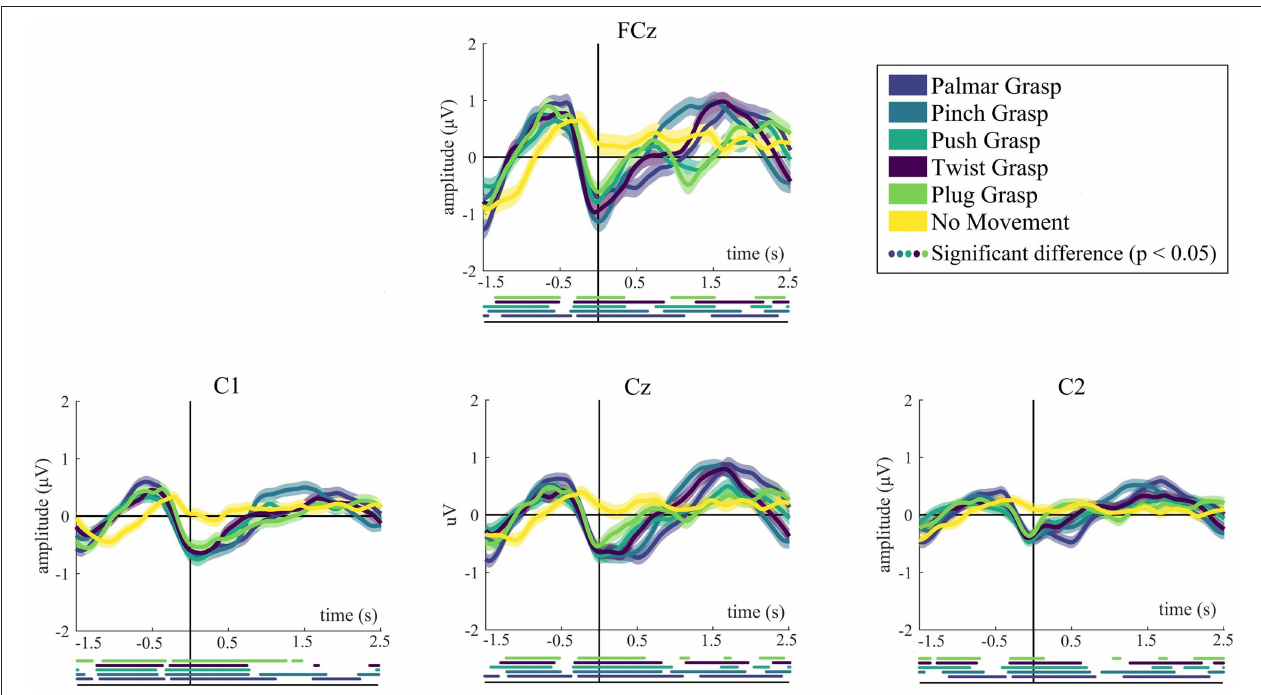
FIGURE 2 | The grand average of all trials of MRCPs for all conditions. Grand average (bold lines) and 95% confidence intervals (shaped areas) for all grasp conditions and the no-movement condition of C1, Cz, and C2. Time = 0s denotes the starting point of movement. Below the axis, we marked significantly different ( p < 0.05) timepoints resulting from the Wilcoxon rank sum test between every reach-and-grasp condition and no-movement